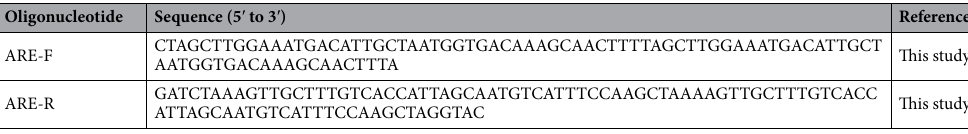
Table 2. ARE oligonucleotide sequences used in this